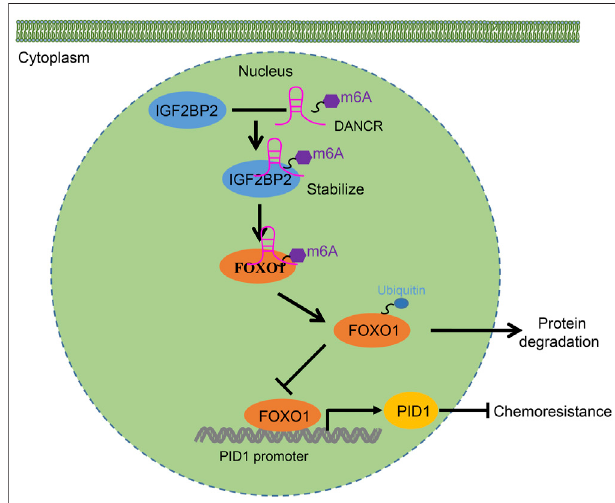
FIGURE 8 | Schematic diagram of the mechanism by which IGF2BP2 affects the resistance of GBM cells to etoposide. IGF2BP2 promotes DANCR expression and stability through FOXO1 ubiquitination-mediated PID1 expression, thereby promoting cancer cell survival and tumor growth as well as engendering the etoposide resistance of GBM cells to